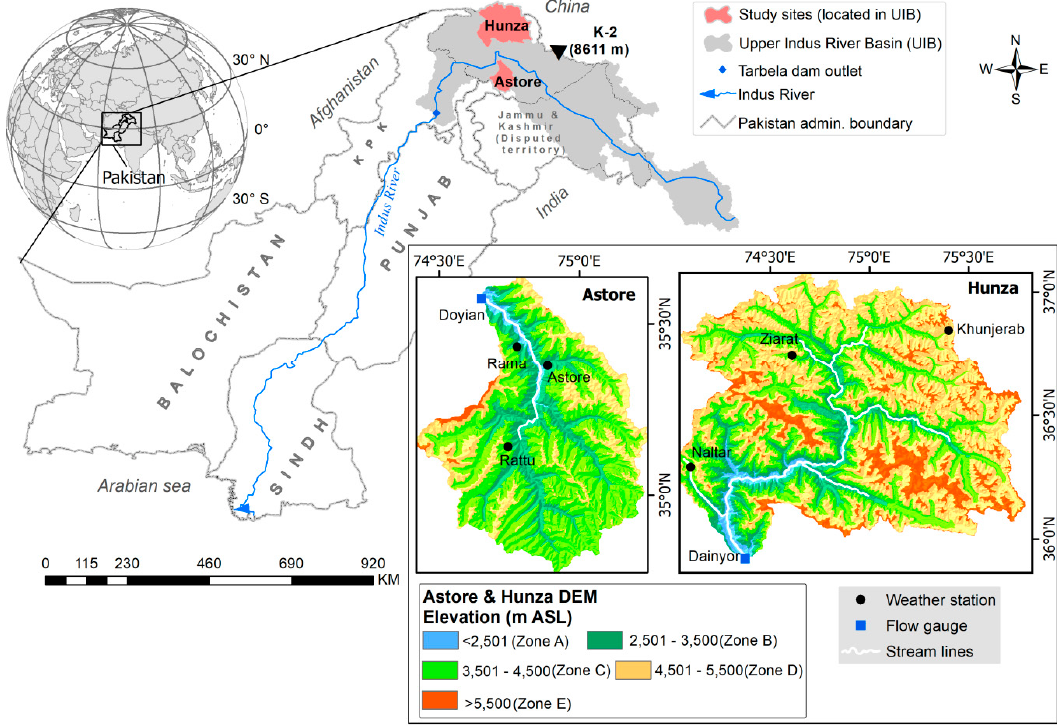
Figure 1. Location map and digital elevation models of the study area (Hunza and Astore basins).